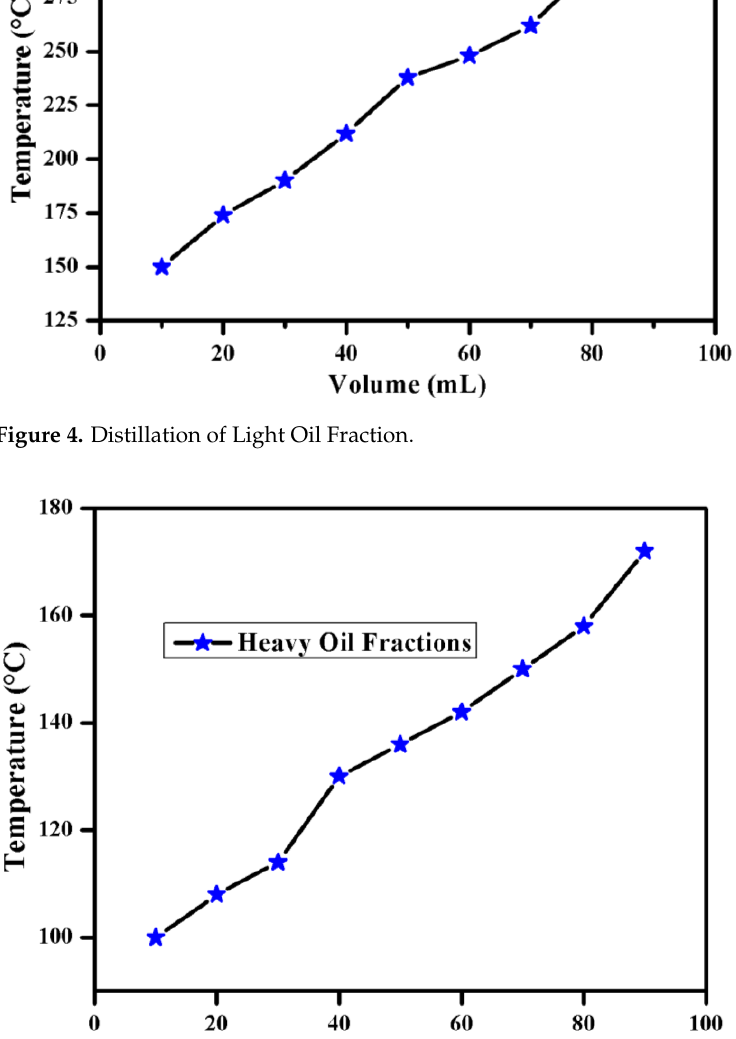
Figure 5. Distillation of Heavy Oil